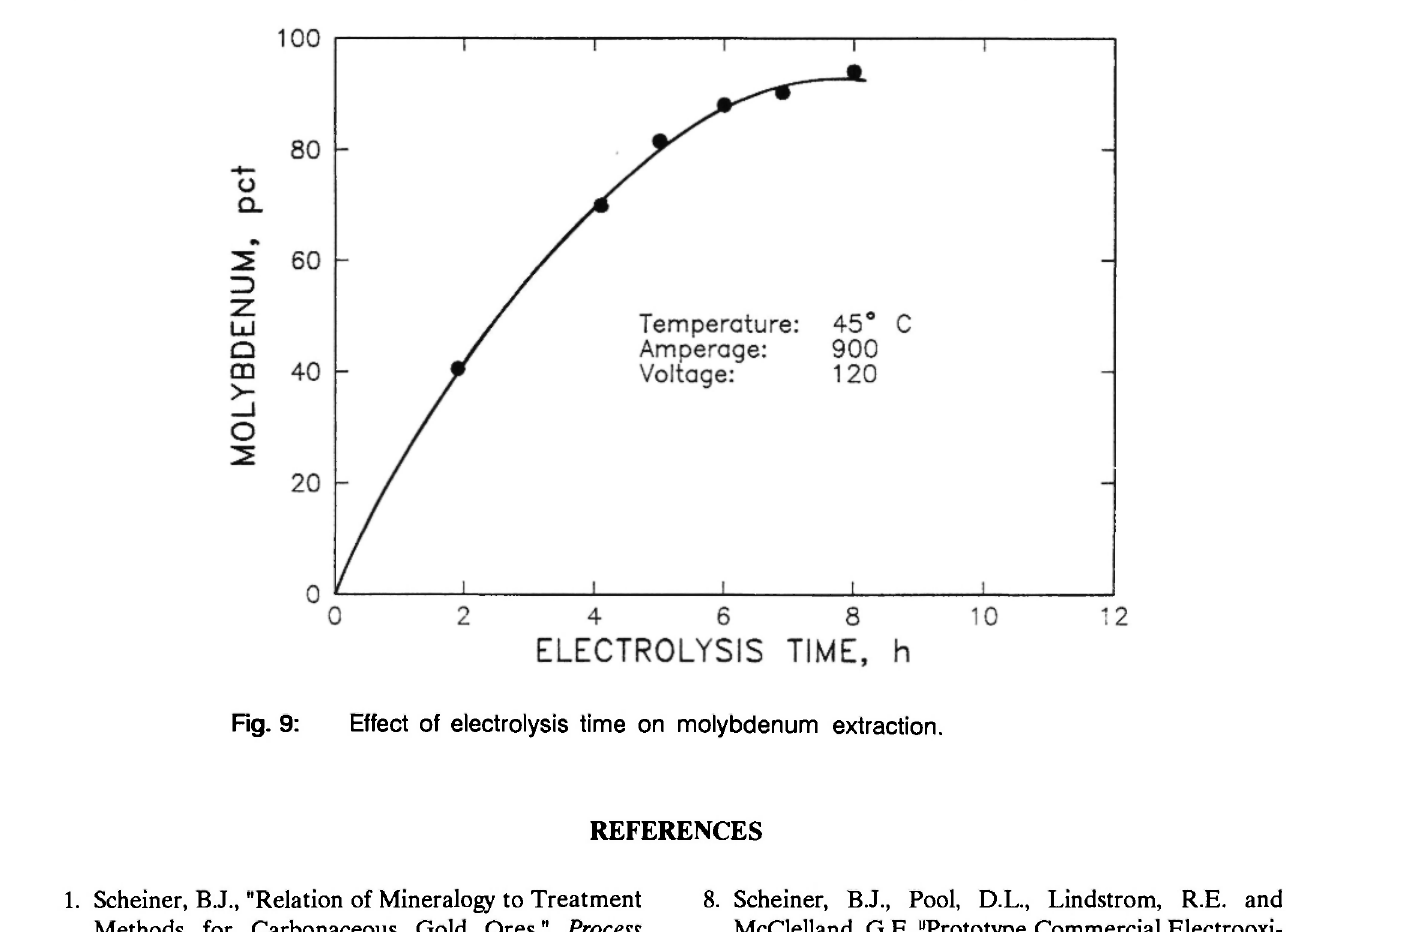
Fig. 9: Effect of electrolysis time on molybdenum